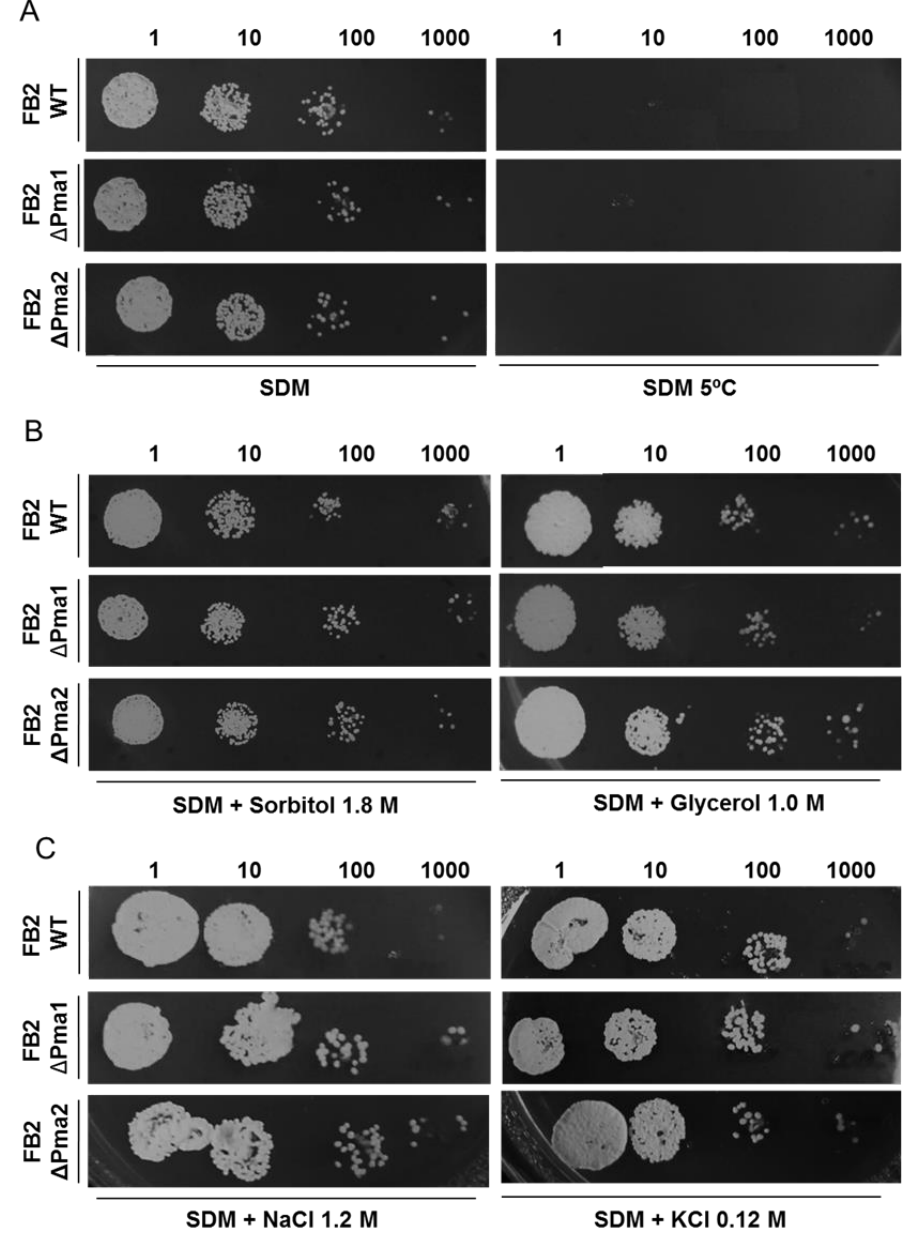
Figure 6. Effect of cold, salt, and osmotic stress on wild-type and mutant strains lacking Pma1 or Pma2. U. maydis wild-type and mutant strains were cultured in SDM for 48 h to determine the effect of thermic (5 °C) ( A ), osmotic (sorbitol and glycerol) ( B ), and salt stress (NaCl and KCl) ( C ) on cell growth (n > or = 3).